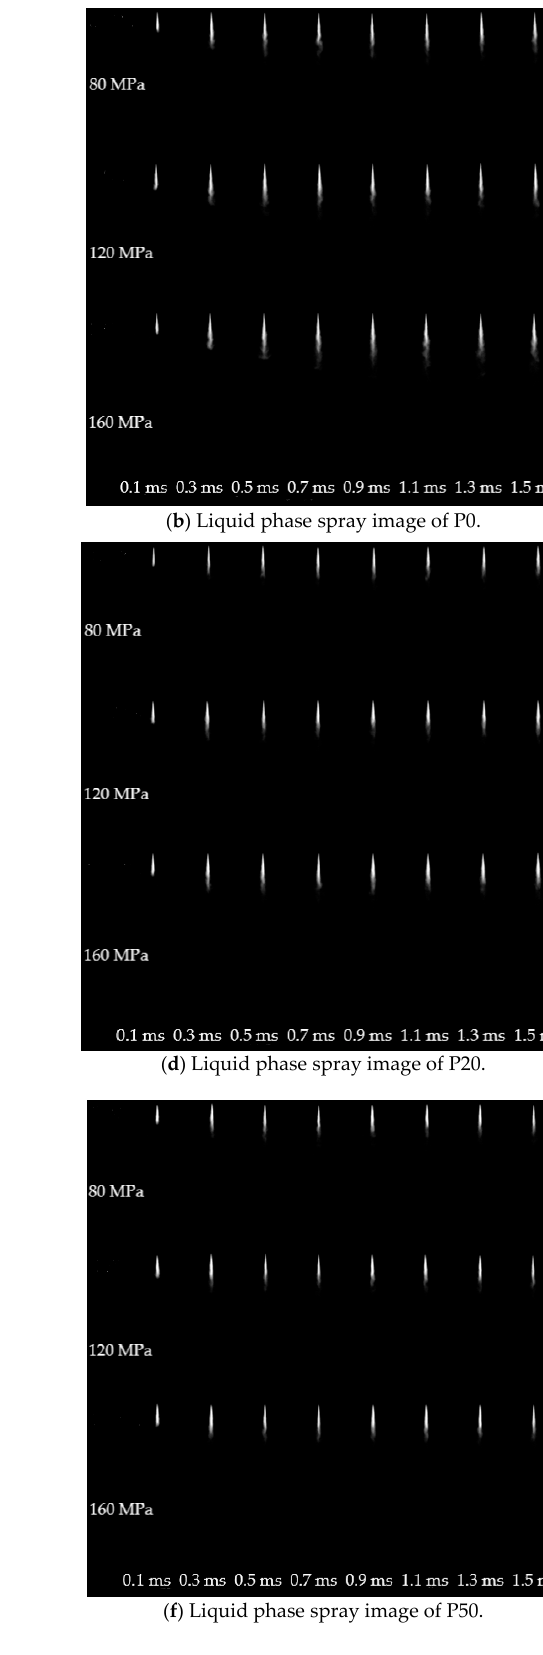
Figure 10. Spray image of three fuels under different